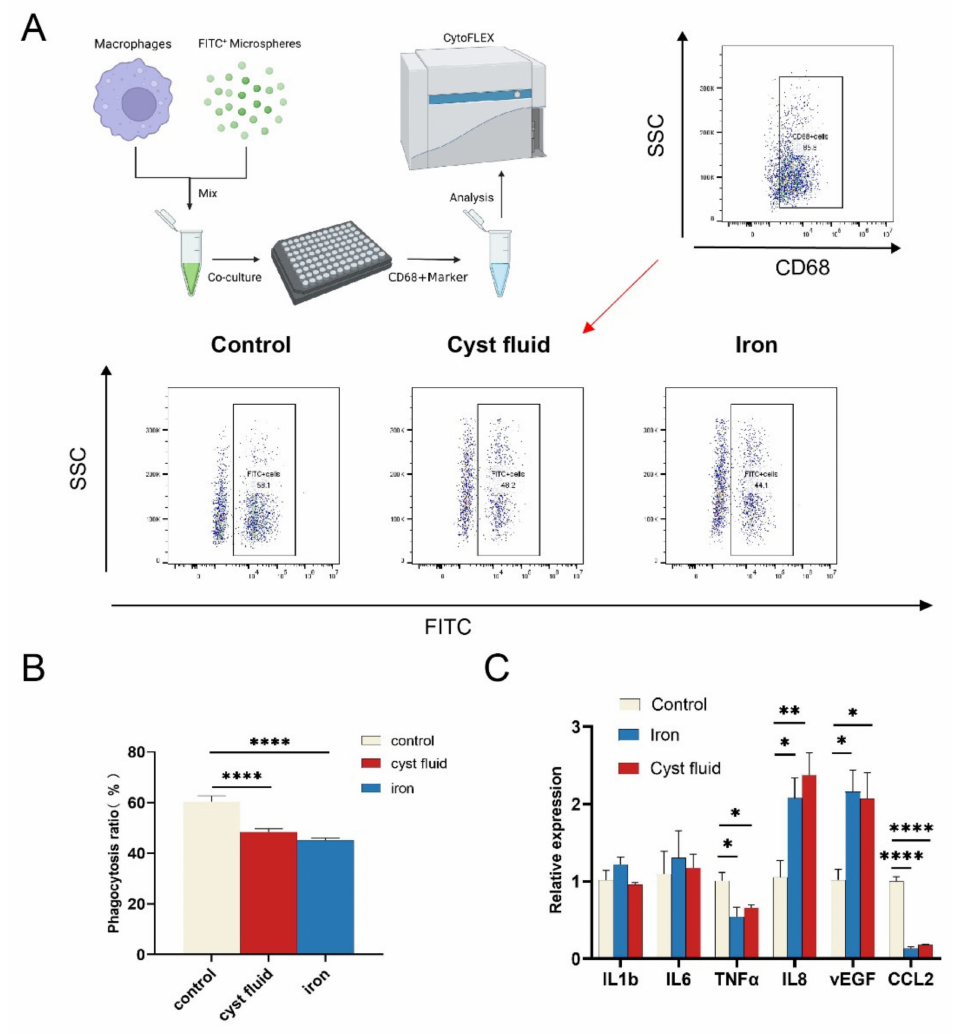
Figure 4. Effects of ferroptosis on macrophage function. ( A ) Representative image of phagocytosis ratio of macrophages treated with cyst fluid or iron verified by flow cytometric analysis. ( B ) Quantification of phagocytosis ratio of macrophages treated with cyst fluid or iron. (**** p <0.0001). Phagocytosis ratio = FITC+CD68+cells/CD68+cells. ( C ) mRNA levels of cytokines expression in cyst fluid-treated (2%) and iron-treated (200 µ g/mL) macrophages for 12 h determined by RT-qPCR. IL1b: interleukin 1 beta; IL6: interleukin 6; TNF α : tumor necrosis factor; IL8: C-X-C motif chemokine ligand 8; VEGFA: vascular endothelial growth factor A; CCL2: C-C motif chemokine ligand 2. * p < 0.05, ** p < 0.01, **** p <